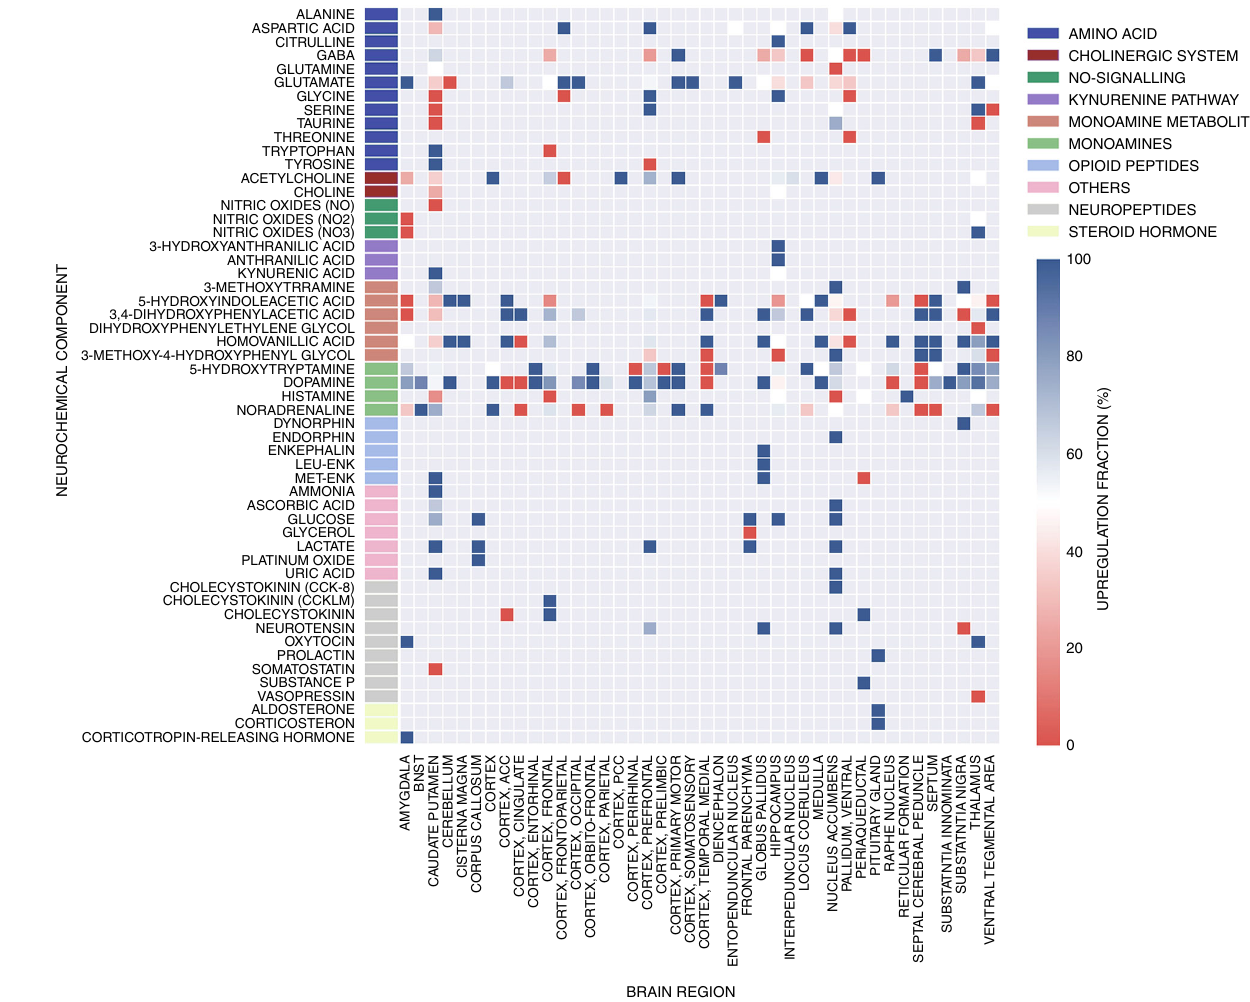
Fig. 3 Frequency of neurotransmitter-brain region pair response upon compound administration. Our analysis highlights the fraction of times compound administration led to an increased (red) or decreased (blue) neurochemical response across each brain region and neurochemical component pair. The visualization contains a total of 1813 compound measurements available across 44 distinct brain regions. It can be seen that neurochemical components such as dopamine (DA) have high frequency of upregulation across different brain regions, indicating a rather unspeci fi c response of this neurotransmitter to drug treatments. Missing measurements are coloured in grey, which also highlights the sparsity of the neurochemical experiments. Neurochemical components are ordered by classi fi cation (indicated via row